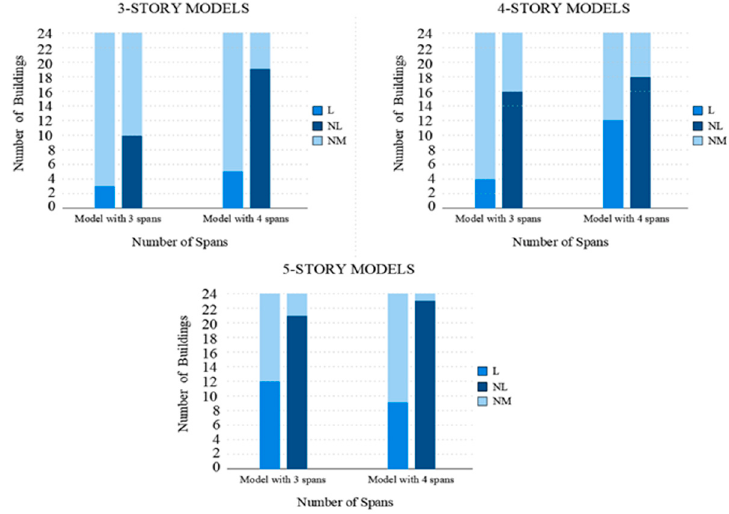
Figure 12. Distribution of buildings with sufficient performance according to the storey num- ber/number of spans.